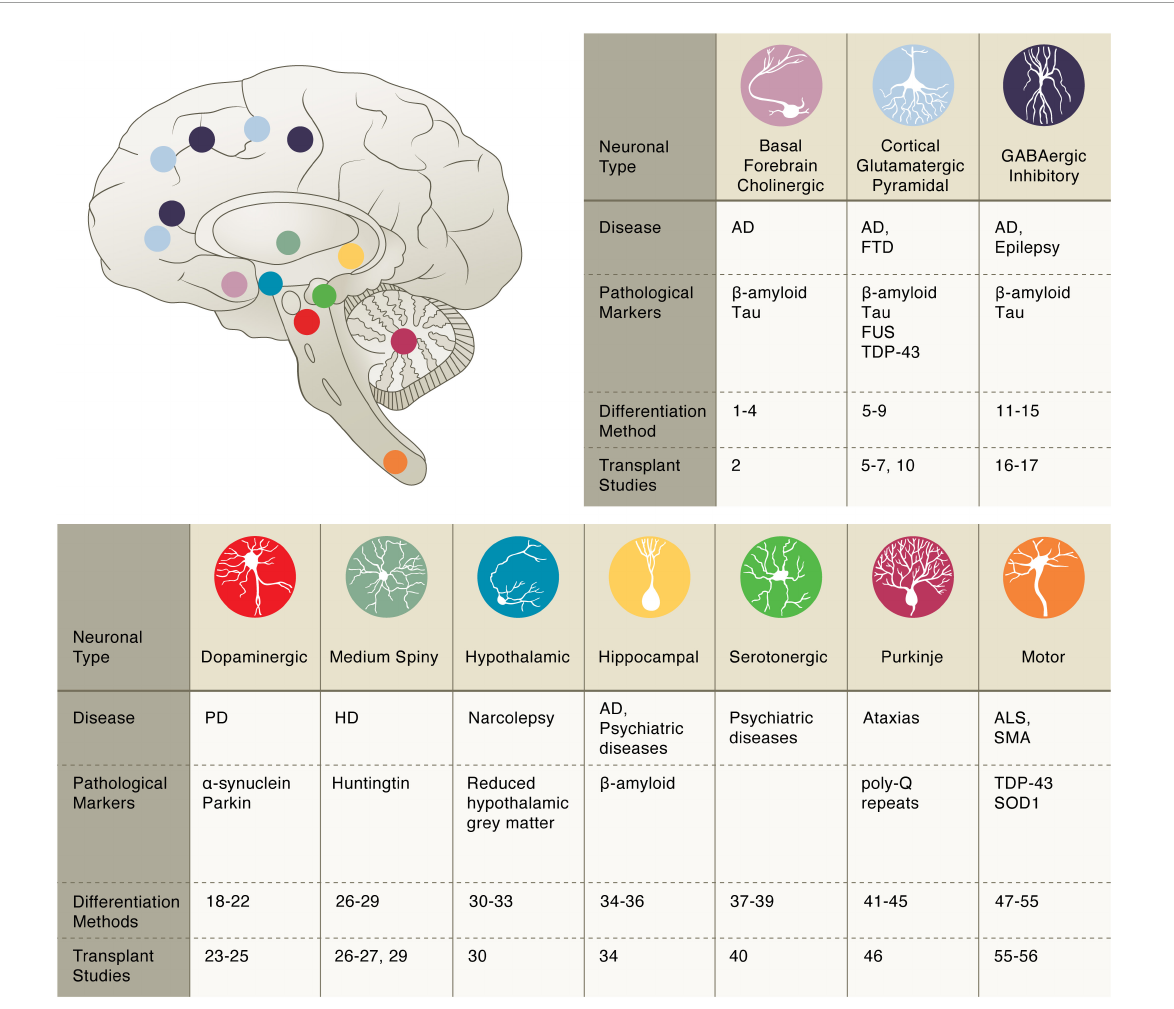
FIGURE1 Pluripotent stem cell differentiation strategies for producing vulnerable neuronal cell types. Basal forebrain cholinergic: diff. 1–4 Bissonnette et al., 2011; Liu et al., 2013a,b; Hu et al., 2016; transpl. 2 Liu et al., 2013a. Cortical glutamatergic: diff. 5–9 Espuny-Camacho et al., 2013;